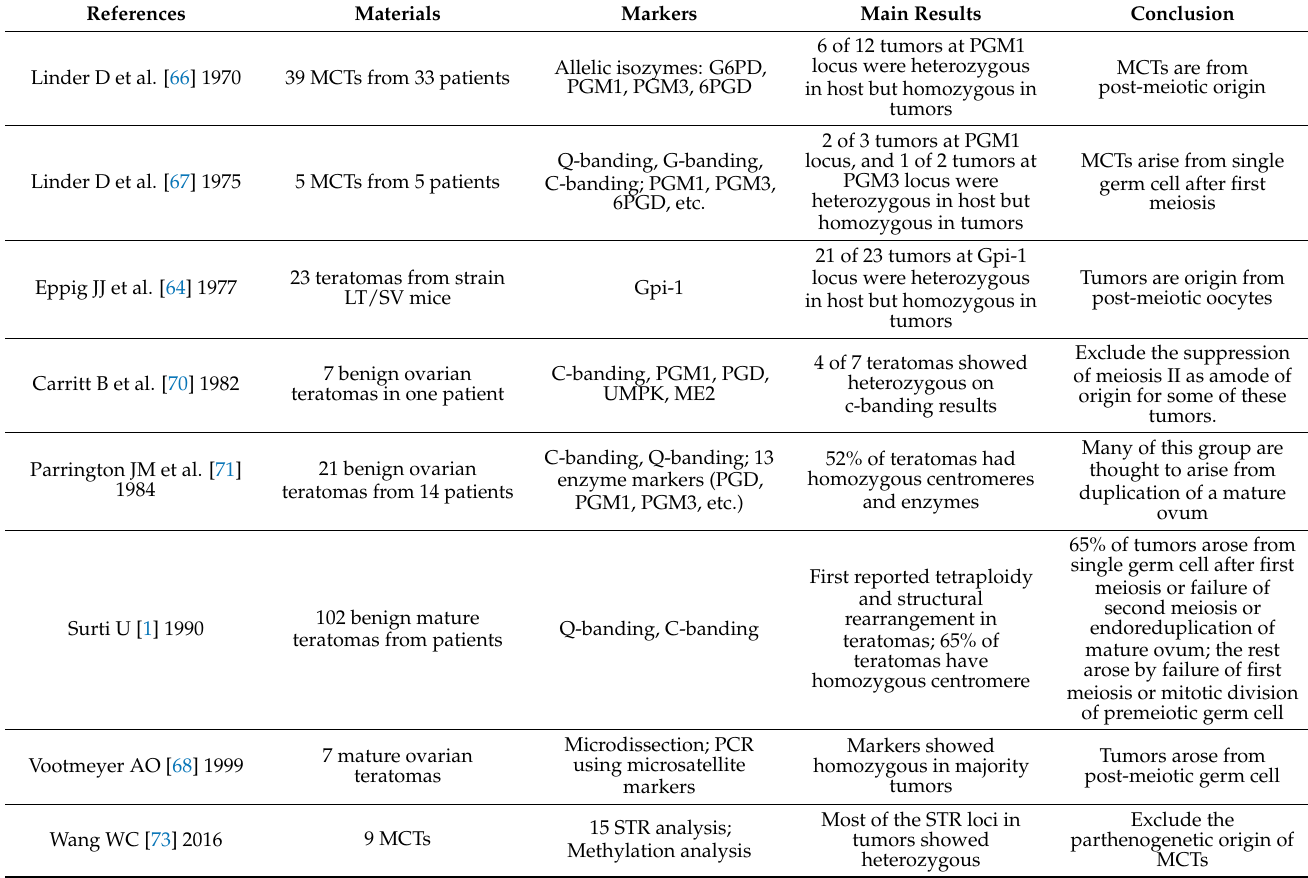
Table 2. The studies of the cellular origin of